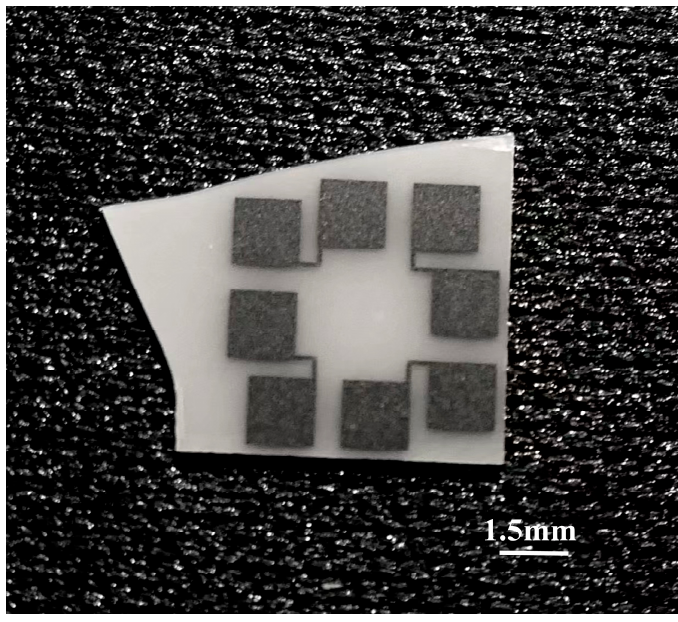
Figure 2. Image of finished Pt RTD sample.